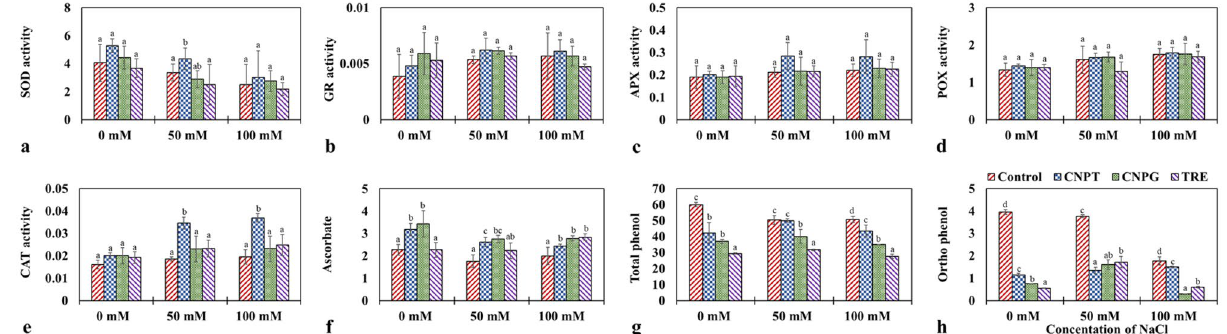
Figure 5. Changes in enzymatic and non-enzymatic antioxidant activities of NaCl stressed Vigna radiata seedlings following the application of CNPT, CNPG and TRE. ( a ) Superoxide dismutase (Enzyme units mg protein −1 ); ( b ) Glutathione reductase (μmol NADPH mg protein −1 min −1 ); ( c ) Ascorbate peroxidase (mmol ascorbate mg protein −1 min −1 ); ( d ) Peroxidase (mmol o-dianisidine mg protein −1 min −1 ); ( e ) Catalase (mol H 2 O 2 mg protein −1 min −1 ); ( f ) Ascorbic acid (mg g −1 f.w.t); ( g ) Total phenol (mg g −1 f.w.t); ( h ) Orthodihydroxy phenol (mg g −1